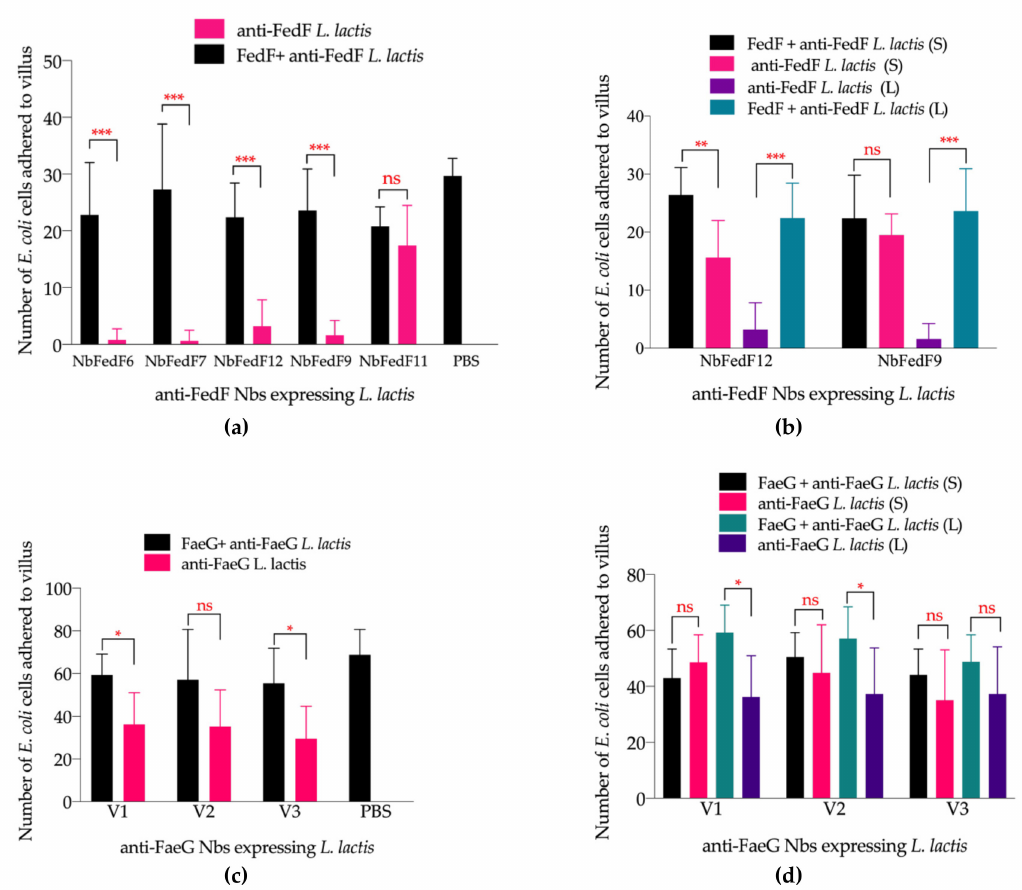
Figure 5. Inhibition of adherence of the F18 + and F4 + E. coli strains to prepared piglet microvilli by L. lactis expressing anti-FaeG and anti-FedF Nb. ( a ) Inhibition of adherence of the F18 + E. coli 107/86 to microvilli in vitro by L. lactis expressing anti-FedF Nbs on the cell surface. All the L. lactis strains showed strong inhibition except for the positive control Nb242 (non-neutralizing anti-FedF Nb) and E. coli strain 107/86 alone in PBS. Adherence inhibition was reversed by pre-incubating Lactococcus strains with purified FedF protein. ( b ) Effect of protein A anchor domain length on the inhibition of F18 + E. coli 107/86 adhesion to microvilli by anti-FedF Nb expressing L. lactis . A short ProtA anchor domain (S) resulted in partial inhibition (magenta), whereas a long ProtA (L) caused nearly complete inhibition (purple). This positive adhesion inhibition was reversed by pre-incubation of the anti-FedF L. lactis strains with FedF (black and blue bars). ( c ) Partial inhibition of F4 + E. coli (C95-72; K88ac) adherence to prepared piglet microvilli by L. lactis expressing surface anti-FaeG Nbs (magenta). This inhibition was reversed by pre-incubation of these Lactococcus strains with purified FaeG (black). All the anti-FaeG L. lactis strains showed partial inhibition. ( d ) Effect of protein A anchor domain on the inhibition of F4 + E. coli C95-72 adhesion to microvilli. A short linker (S) did not inhibit adhesion (magenta), whereas a long linker (L) resulted in partial inhibition (purple). Pre-incubation of the anti-FaeG Lactococcus strains with FaeG (black and blue) allowed adhesion. Adherence was measured as counts of E. coli cells attached to 250 µ m villus length. Level of significance: p > 0.05 (ns), p ≤ 0.05 (*), p ≤ 0.002 (**), and p ≤ 0.001